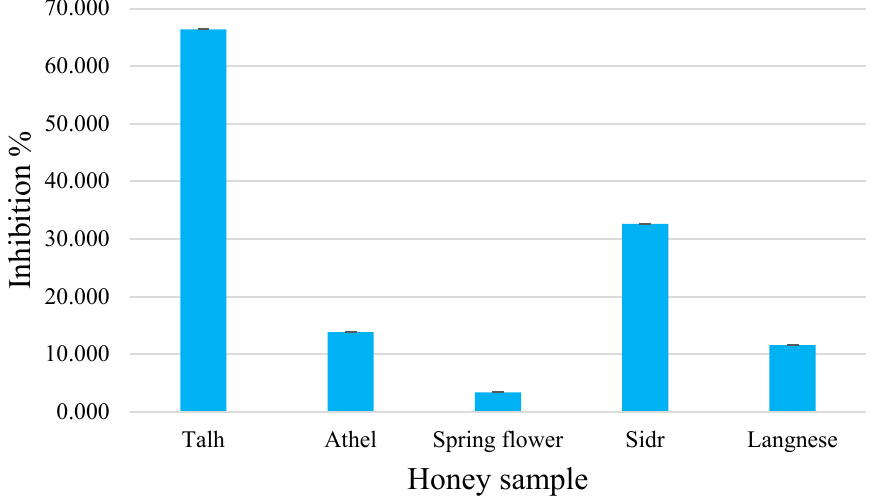
Figure 3. DPPH scavenging activity of honey samples.